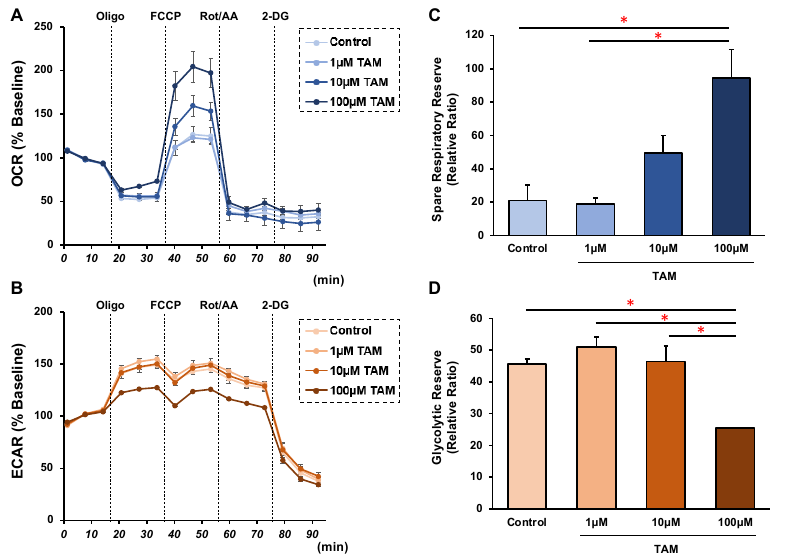
Figure 3. Effects of different concentrations of tamsulosin (TAM) on the cellular metabolic phenotype of the 2D cultured ARPE 19 cells. 2D cultured ARPE 19 cells at Day 5 were prepared in the absence or presence of 1 μ M, 10 μ M or 100 μ M tamsulosin (TAM), and each sample was subjected to a real ‐ time metabolic function analysis using a Seahorse XFe96 Bioanalyzer. Measurements of oxygen consumption rate (OCR, panel ( A )) and extracellular acidification rate (ECAR, panel ( B )) before drug injections (at baseline) were represented as 100% and their changes were determined by the following injections: oligomycin (a complex V inhibitor), FCCP (a protonphore), rotenone/antimycin (complex I/III inhibitors), and 2 ‐ DG (a hexokinase inhibitor). Relative ratios of the Spare respiratory Reserve and Glycolytic Reserve are plotted in panel ( C , D ), respectively. Oligo = oligomycin, Rot/AA = rotenone/antimycin A, 2 ‐ DG = 2 ‐ deoxyglucose. Fresh preparations were used in all experiments ( n = 3). Data are presented as the mean ± the standard error of the mean (SEM). * p < 0.05 (ANOVA followed by a Tukey’s multiple comparison test).